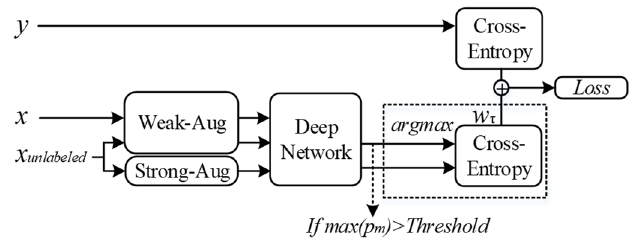
Figure 8. Pipeline of Fix-match.